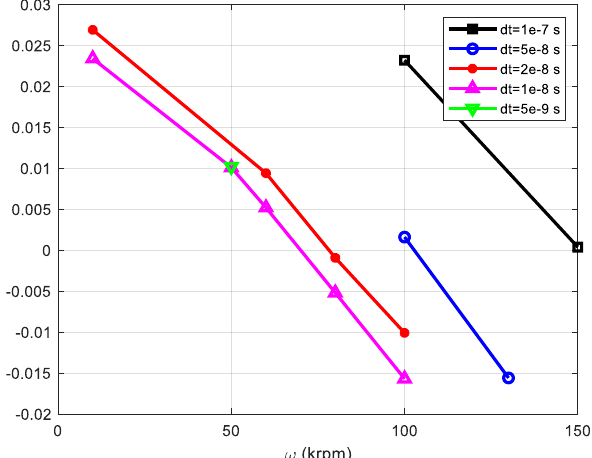
Figure 11. Damping ratio vs. rotational speed obtained with different time steps; the grid is 31 × 96.